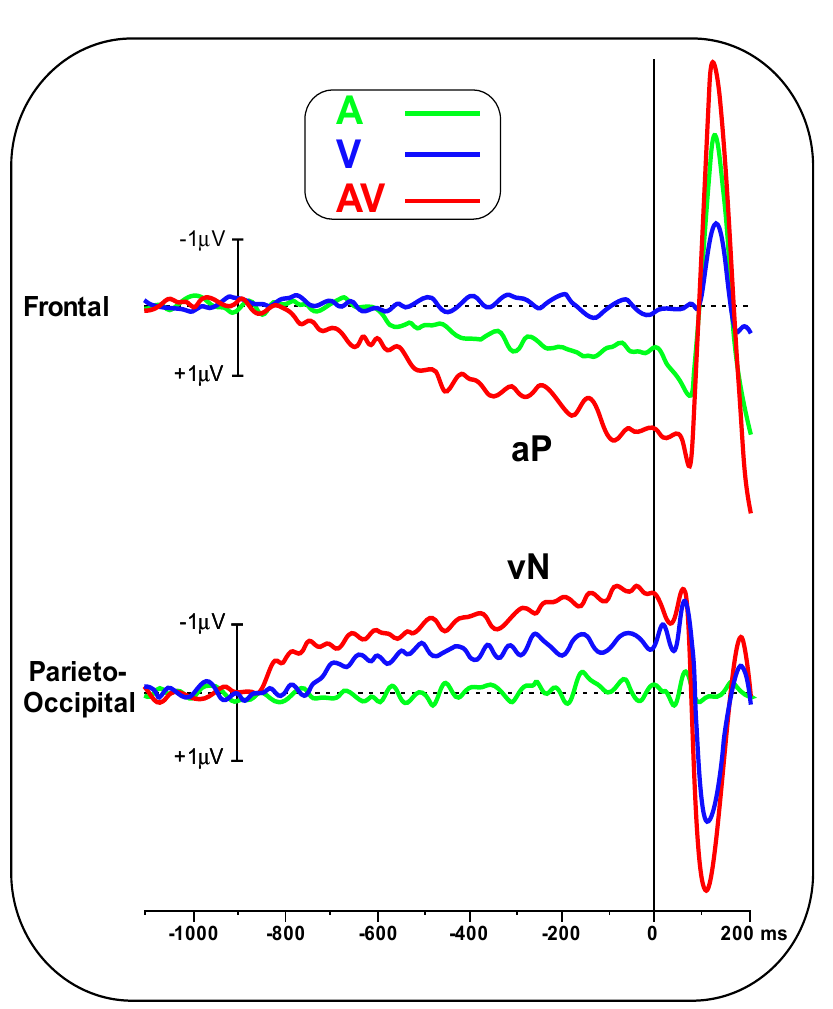
Figure 2. Pre-stimulus ERP in the A, V and AV conditions at the frontal pool, showing the aP component, and the parieto-occipital pool, showing the vN.